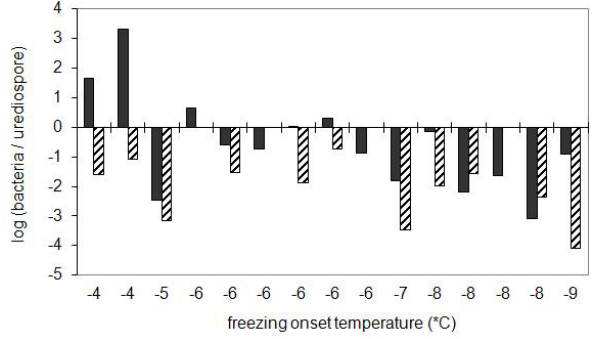
Fig. 2. Frequencies of urediospores carrying total bacteria and Pseu- domonas syringae . Frequencies are presented as the log of total bac- teria (solid bars) or P. syringae (hatched bars) per urediospore for samples ranked in the order of decreasing freezing onset tempera-